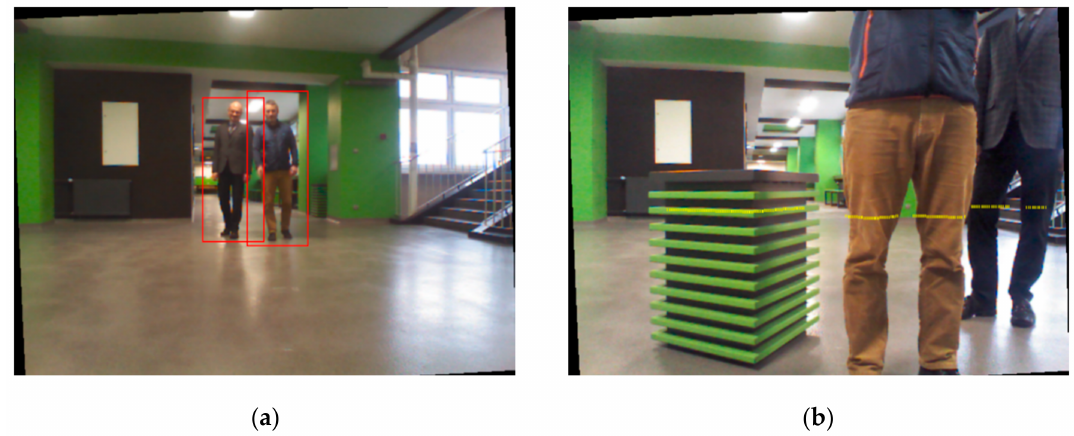
Figure 18. Processed images: ( a ) after human detection, and ( b ) merged vision and laser